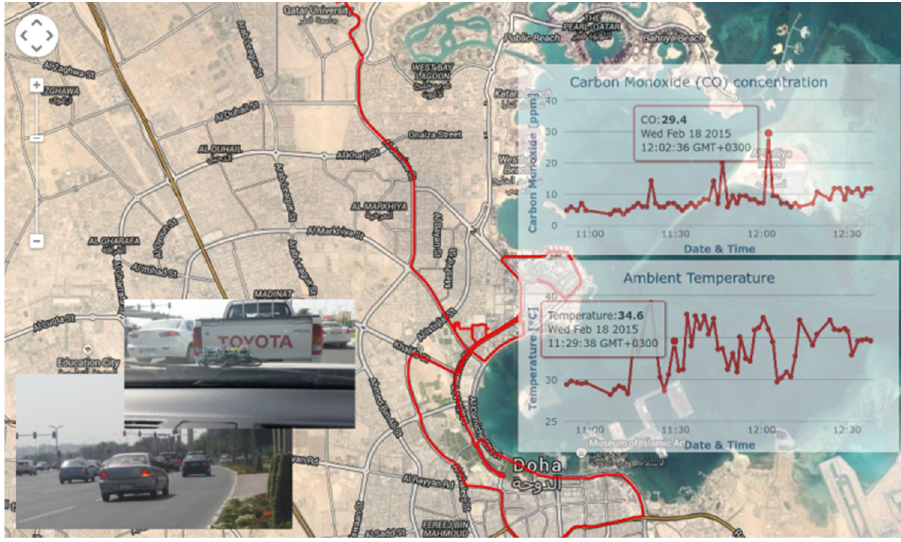
Figure 5. Example of gas sensors (here NO 2 ) thermal drift analysis from 0 to 45 °C.